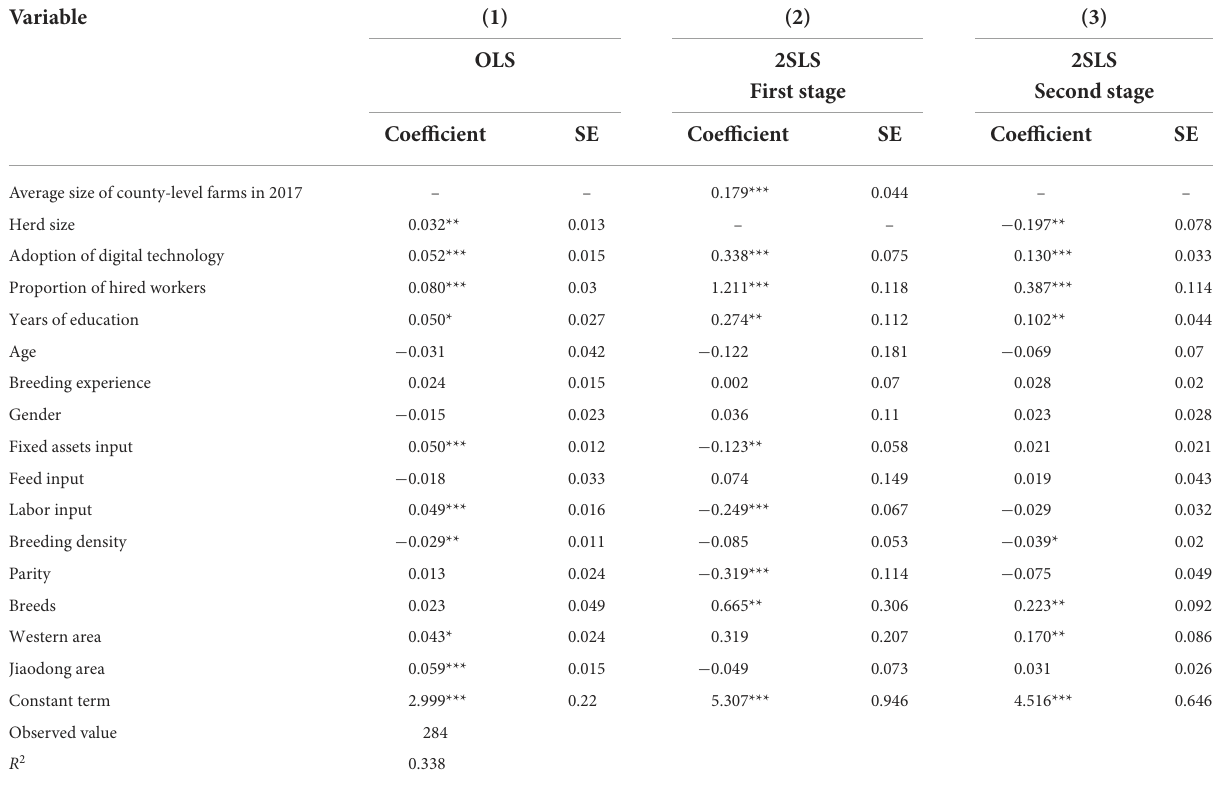
TABLE 2 Empirical results on the impact of herd size on the dairy cow yield.